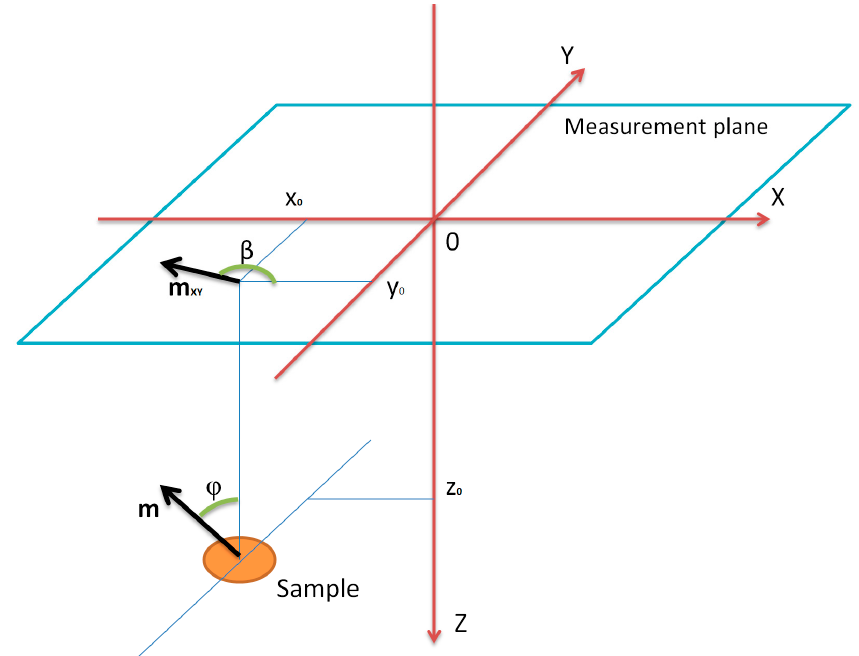
Figure 3. Measurement plane and sample geometrical values.